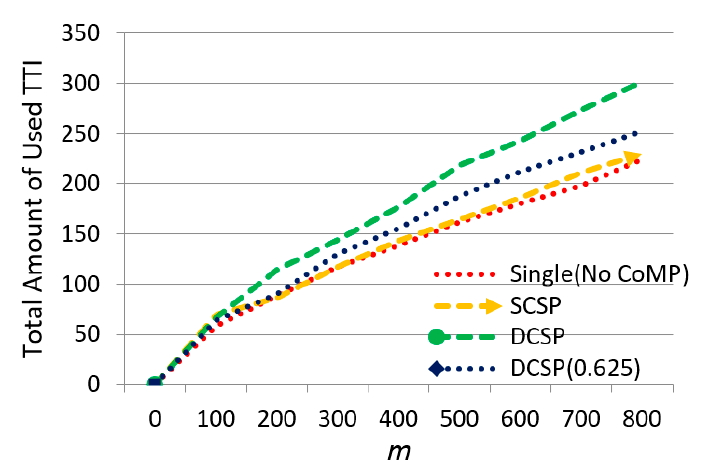
Figure 14. The effect of ᶆ on average cluster size.